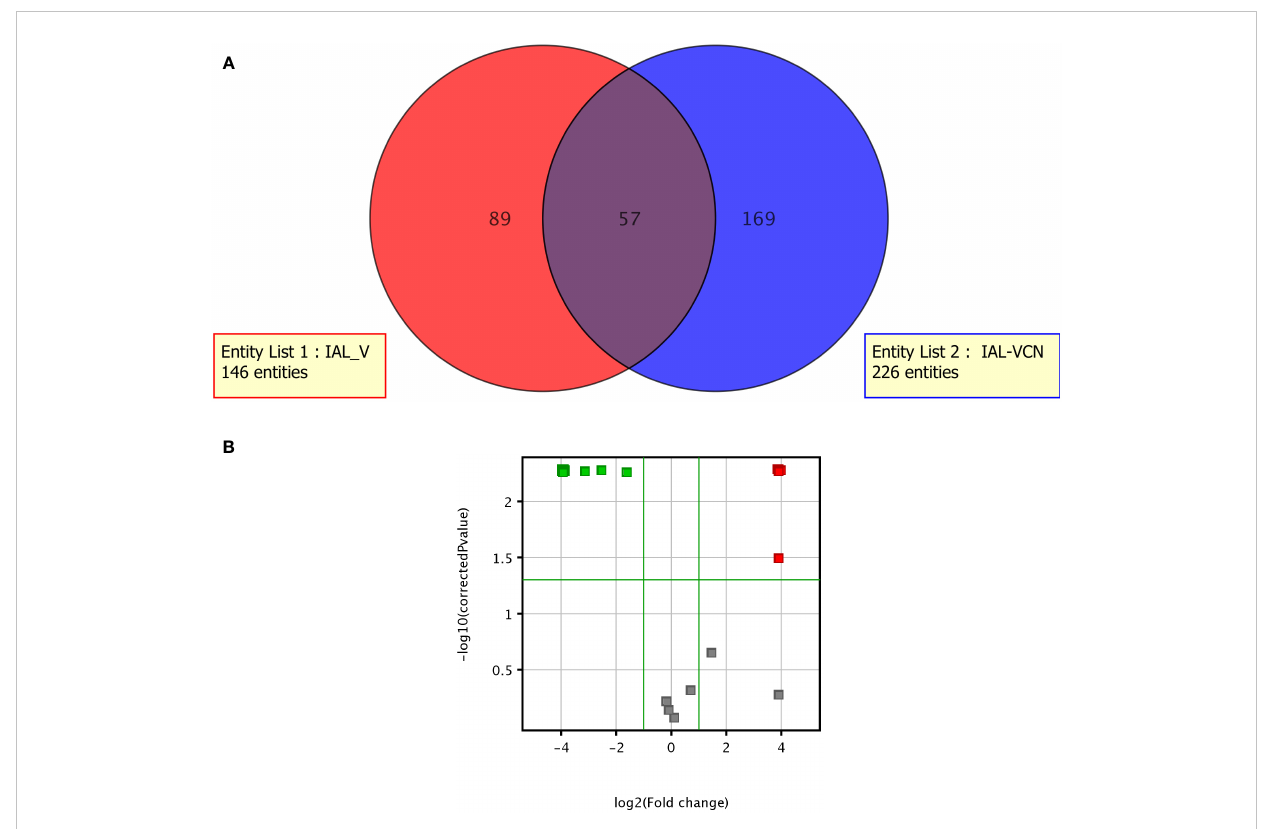
FIGURE 6 Metabolome of C. jejuni VT and the VBNC. (A) Venn diagram; (B) Volcano Plot demonstrating the most expressed (in red) and least expressed (in green) metabolites in VT compared to